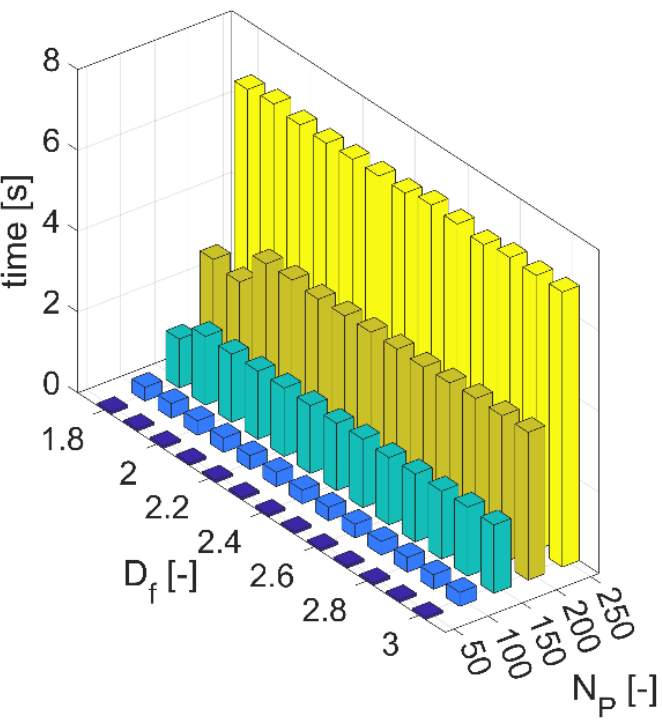
Figure 6. Simulation time required to generate agglomerates (with N p = 50:50:250 ; D f = 1.8:0.1:3; k = 1) by employing the MPTSA model (with R p = 260 µ m and σ = 0 µ